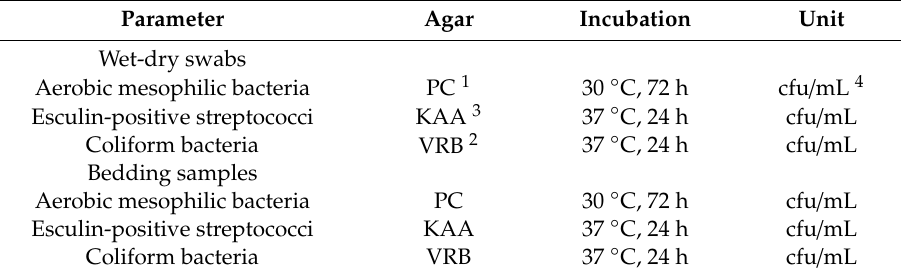
Table 1. Overview of the laboratory analyses carried